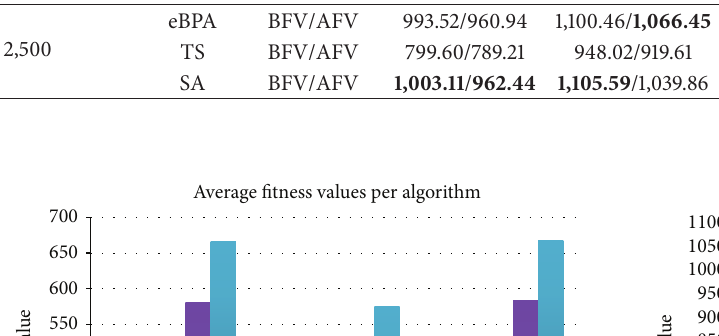
Table 5: Statistics of the best fitness values (BFV) and average fitness values (AFV) for the class of 2,500 jobs. Number of jobs Methods Fitness values